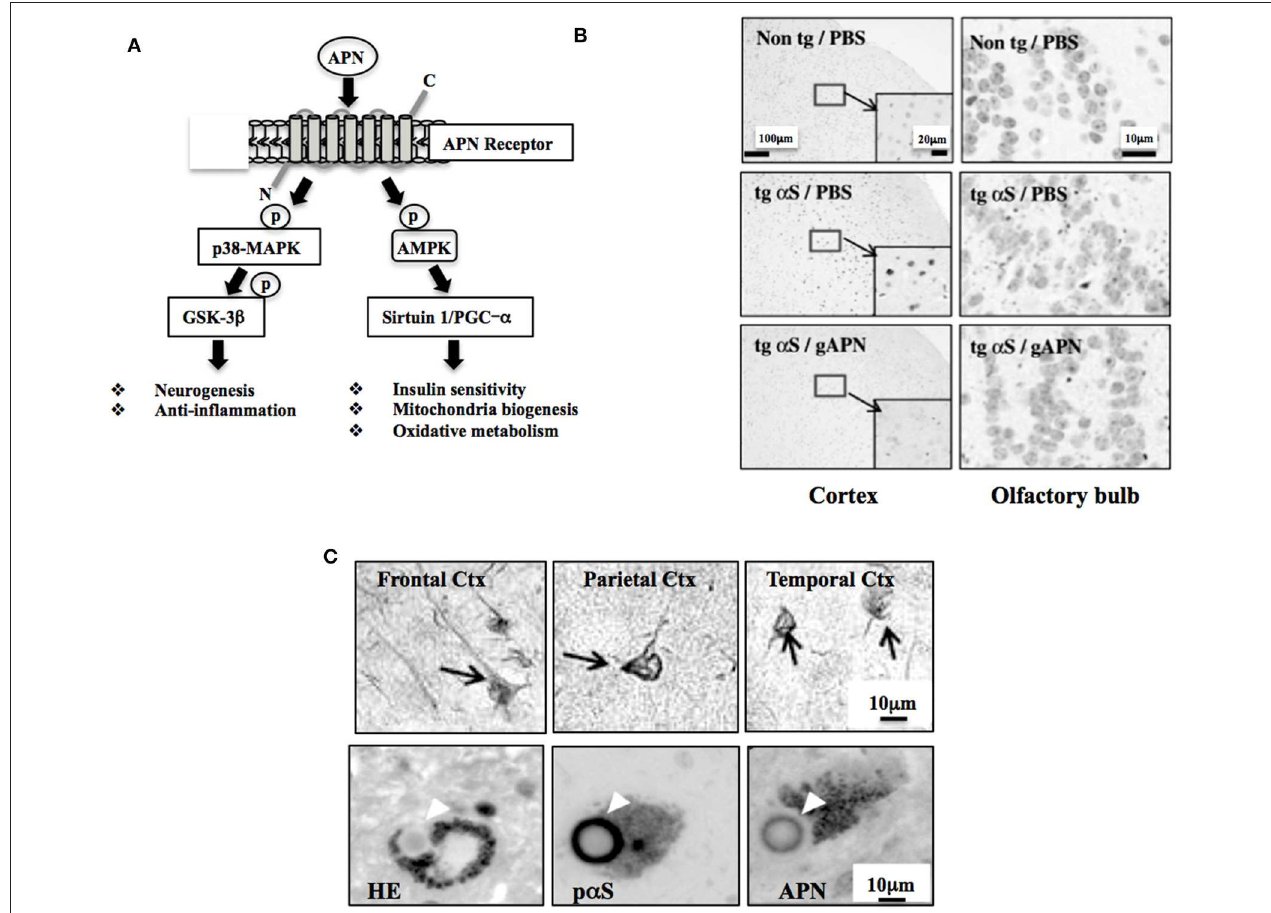
FIGURE 1 | Neuroprotective and neurodegenerative effects of APN. (A) Schematic of APN signaling pathway. AMPK regulates various intracellular signaling molecules, such as sirtuin and PGC-1 α , leading to stimulation of insulin sensitivity, mitochondrial biogenesis, and oxidative metabolism. APN also activates p38-MAPK, inhibiting GSK-3 β activity, leading to stimulation of neurogenesis and suppression of neurodegeneration. Modified from Waragai et al. (1) with permission. (B) APN ameliorates neurodegeneration in a mouse model of α -synucleinopathies. Globular APN [gAPN, 0.1 mg/ml in 10 µ l phosphate buffered saline (PBS)] or PBS alone (10 µ l) was given intranasally to α S tg mice (male, 3 months old) or wild-type littermates every 3 days for 2 months. Brains were analyzed immunohistochemically (anti-phospho- α S). Representative images of the cortex and olfactory bulb are shown. Insets show a higher magnification of the cortex. Reprinted from Sekiyama et al. (20) with permission. (C) Involvement of APN in the pathogenesis of neurodegenerative diseases, including AD and α -synucleinopathies, including Parkinson’s disease and dementia with Lewy bodies. Immunohistochemical staining using a polyclonal anti-APN C-terminal